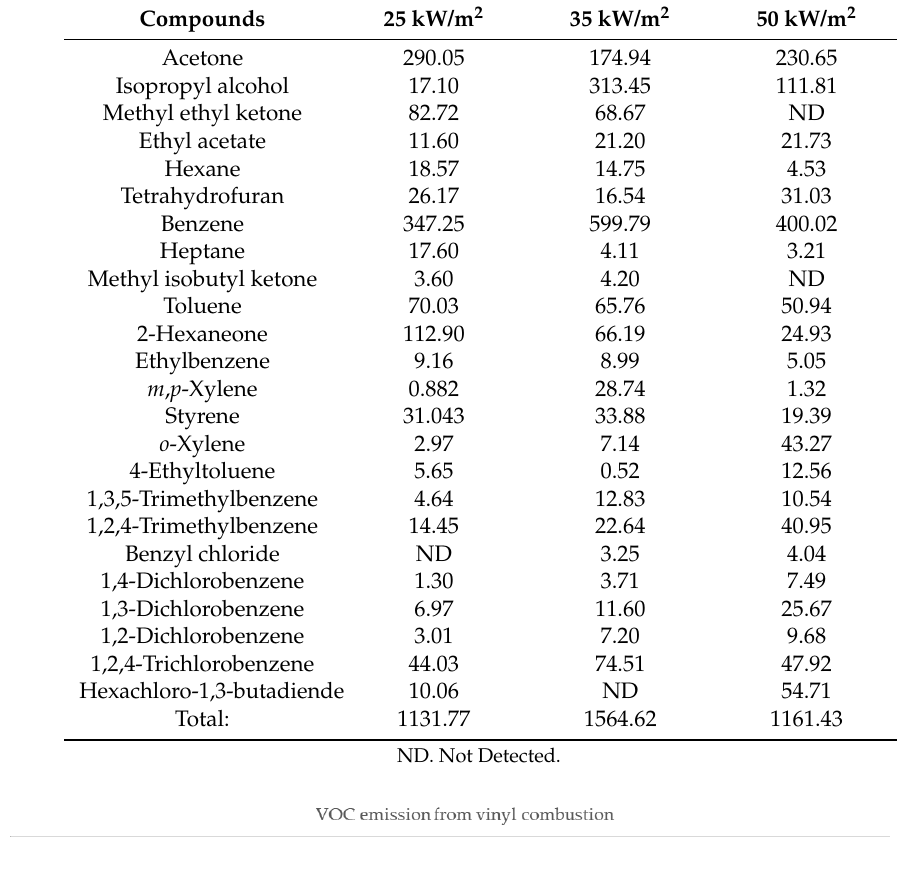
Table 3. Experimental results (ug/m 3 ) of VOC from vinyl combustion.